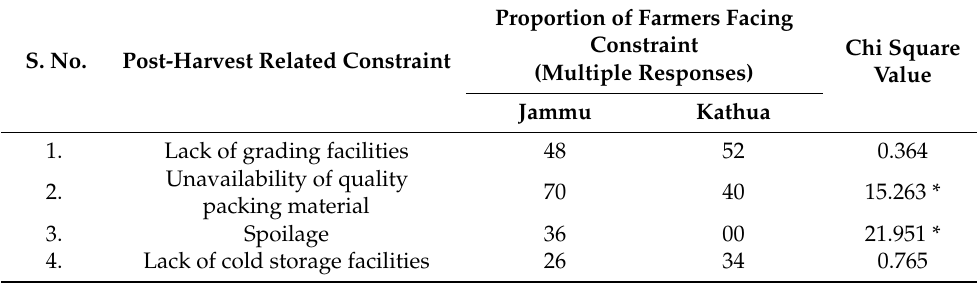
Table 16. Comparison of post-harvest-related constraints faced by farmers of Jammu and Kathua district.